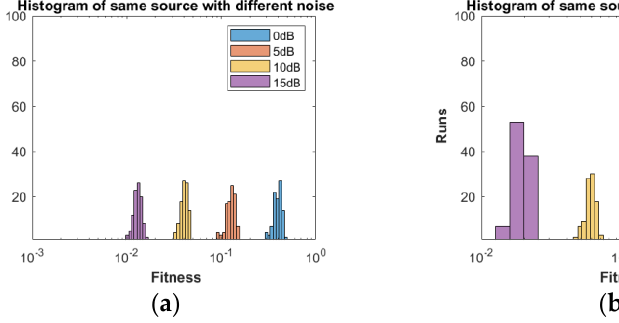
Figure 11. Histogram with Different Noises: ( a ) Two Sources; ( b ) Three Sources; ( c ) Four Sources. For the second scenario, the same number of sources as the first scenario is taken into account, i.e., two sources, three sources and four sources. A different noise level is added to each of them in turn and in steps, i.e., first, two sources are considered and initially, the 0 dB noise is added to these two sources and the data are obtained for 100 runs of the proposed scheme FPA. Next, each set of data is obtained for 100 independent runs of the